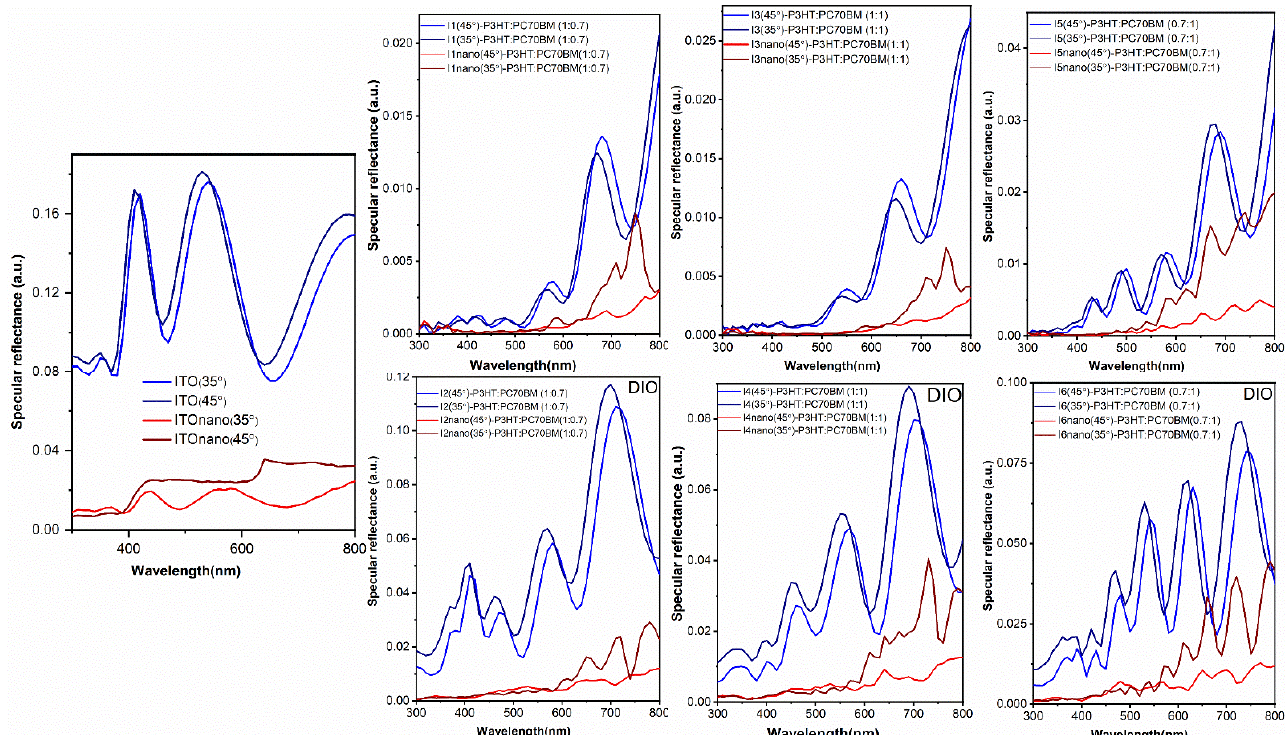
Figure 5. Specular reflectance curves (at two different incidence angles) of the flat and patterned ITO electrodes and of the organic films deposited by MAPLE on these substrates from the targets prepared without and with DIO.